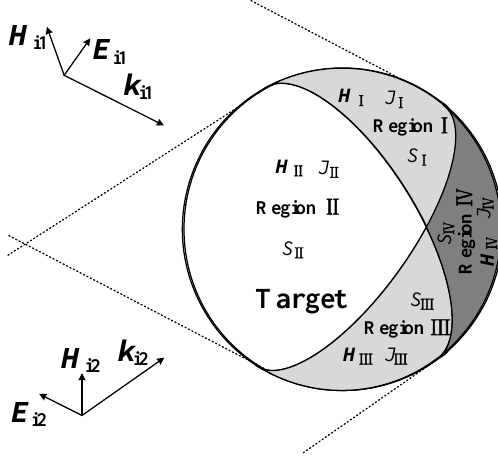
Figure 4. An arbitrary object illuminated by two plane waves.